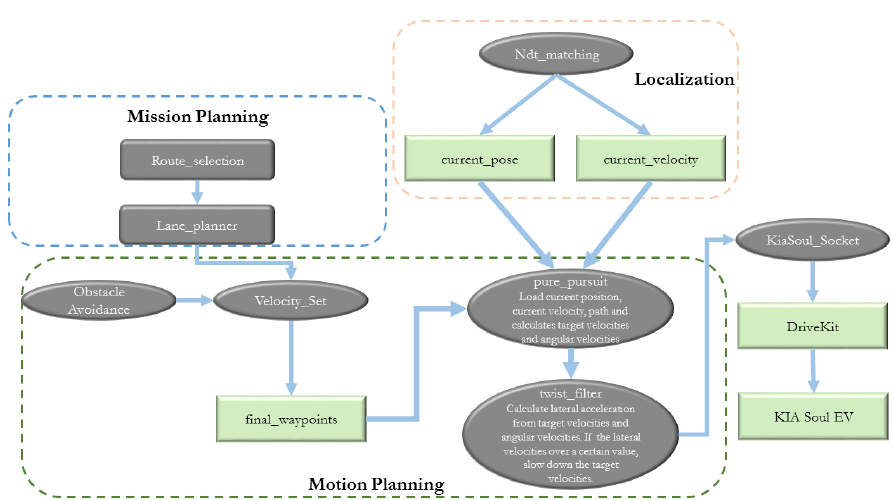
Figure 10. The architecture of the planning module is shown. The planning module contains Mission and Motion planning as its most vital modules. Mission planning generates the lane for routing for the autonomous vehicle using lane planner. Motion planning plans the path and keeps the autonomous vehicle to follow that path. The flow of information is shown above (Best viewed in color).